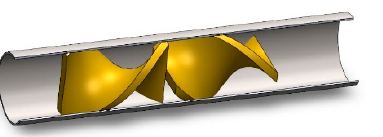
Figure 1. 3D model drawing of a standard Kenics Static Mixer.